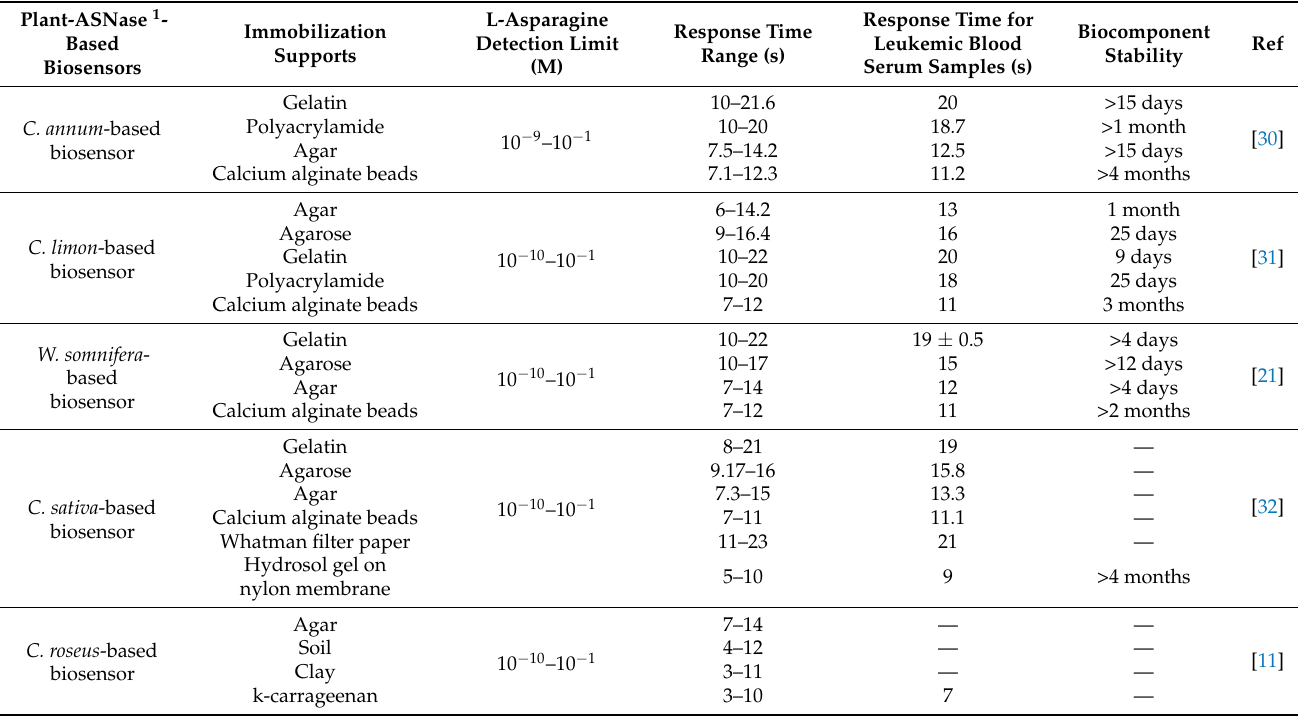
Table 3. Plant-ASNase-based biosensors, immobilization supports, L-asparagine detection limit (M), response time range (s), response time for leukemic blood serum samples (s) and biocomponent